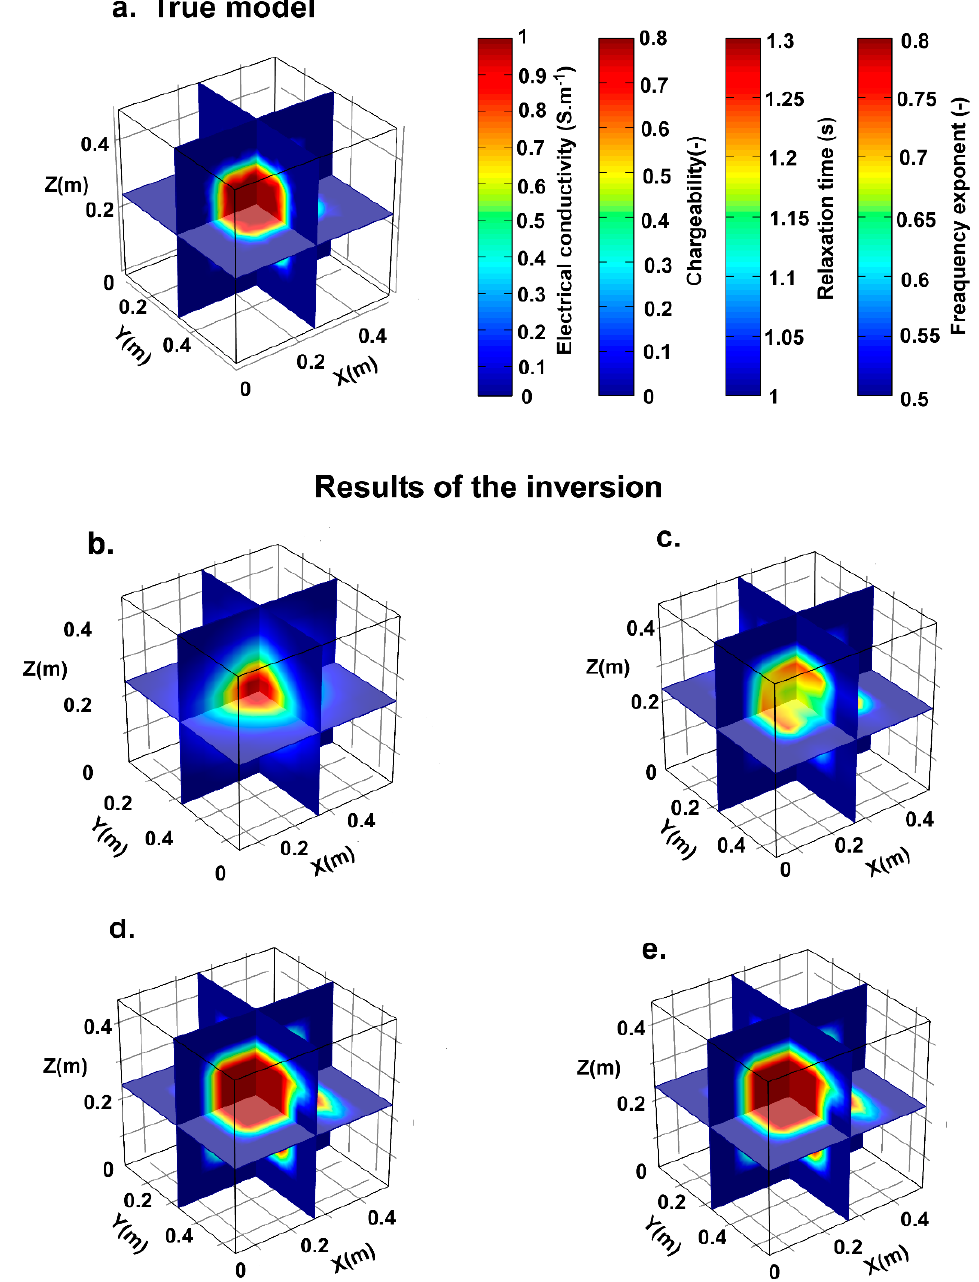
Figure 20. True and estimated Cole–Cole parameter distributions using a source-current-density approach. We use 24 electrodes and only 2 current injections to reconstruct the distribution of the Cole–Cole parameters. ( a ) True distribution of the Cole–Cole parameter models. ( b ) Estimated electrical conductivity ( σ ) at Iteration 4 (RMS = 0.8%, 5% Gaussian noise added to the synthetic data). ( c ) Estimated intrinsic chargeability at time 0 ( M ). ( d ) Estimated relaxation time ( τ ). ( e ) Estimated frequency of Cole–Cole exponent ( c ). Modified from